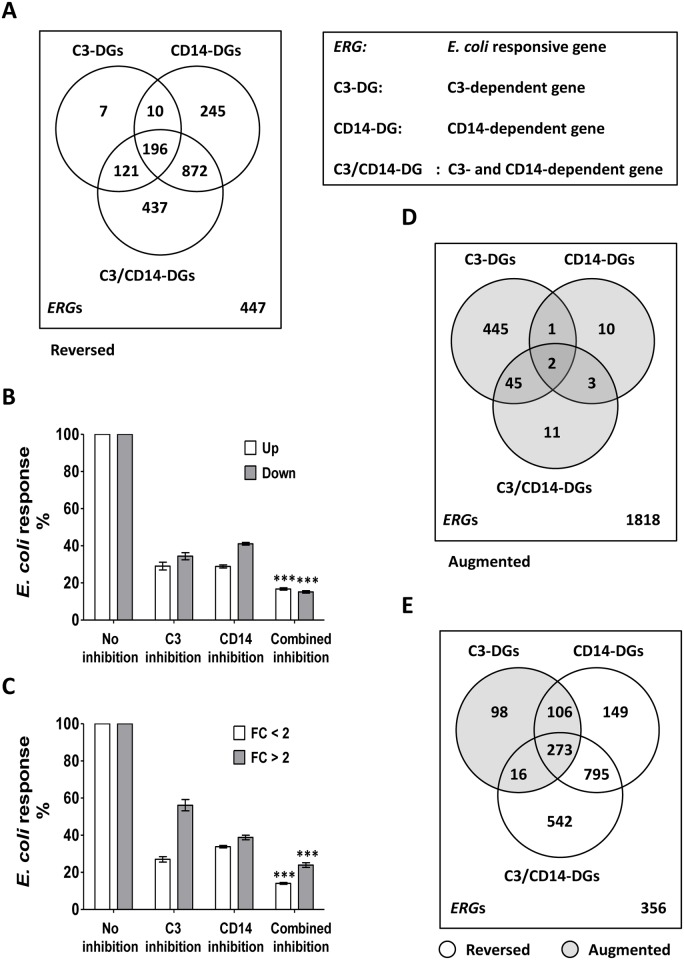
CD14 and/or C3 inhibition of the transcriptional response to E. coli.A, The diagram shows common and specific groups of reversible C3-dependent genes (C3-DGs), CD14-DGs and C3/CD14-DGs DGs. Common genes are encompassed by more than one circle. The sum of all numbers within the diagrams equals the total number of ERGs (n = 2335). Numbers of ERGs which belong to none of the respective DG groups are indicated at the bottom right of the diagram. B and C, The remaining E. coli-induced transcriptional responses of reversible ERGs (in % of total) in the presence of inhibitors were derived from the transcriptional response in the presence of inhibitors of C3 (n = 334), CD14 (n = 1323) or both (combined inhibition; n = 1626) divided by the uninhibited response (set to 100%). Data are shown for up- and down-regulated ERGs (B), and for ERGs with fold change (FC) responses above (FC<2) or below two-fold (FC<2) (C). Data are given as mean and SEM. The significances of the differences between combined inhibitory effect and single inhibitory effects were determined by Two-way ANOVA and Bonferroni post-testing (***, p<0.001). D and E, The Venn diagrams show augmentable C3-DGs, CD14-DGs and C3/CD14-DGs (D) or augmentable C3-DGs (gray circles) compared to reversible CD14-DGs and C3/CD14-DGs (white circles) (E). The total numbers of DGs are listed in Table 1.